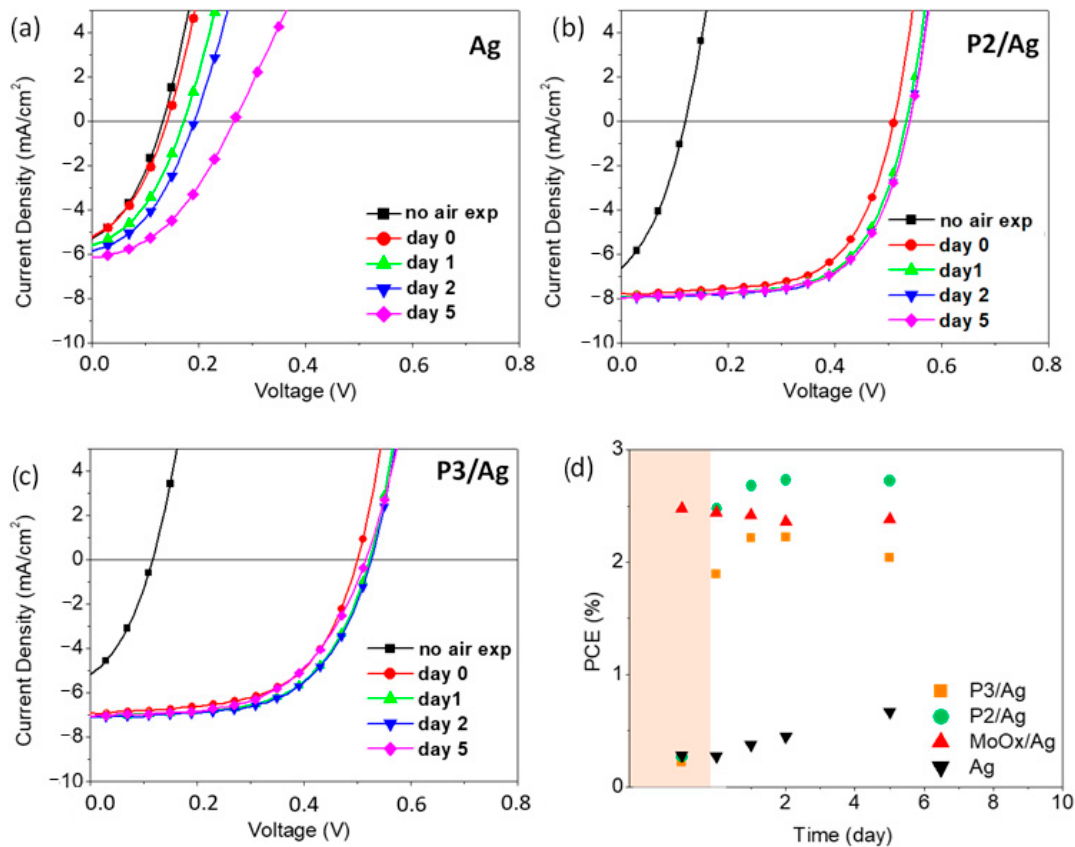
Figure 6. Evolution of the J–V curves and PCEs of devices with inverted geometry as a function of time of storage under ambient atmosphere under AM1.5G irradiation at 100 mW/cm 2 . Top electrode: ( a ) pristine Ag; ( b ) P2 /Ag; ( c ) P3 /Ag; and ( d ) PCEs of pristine Ag, MoOx/Ag, P2 /Ag, and P3 /Ag; before air exposure: pink background; after air exposure: white background. The data at day 0 refers to the devices exposed to air for 15 min, similar to Figure 4c.